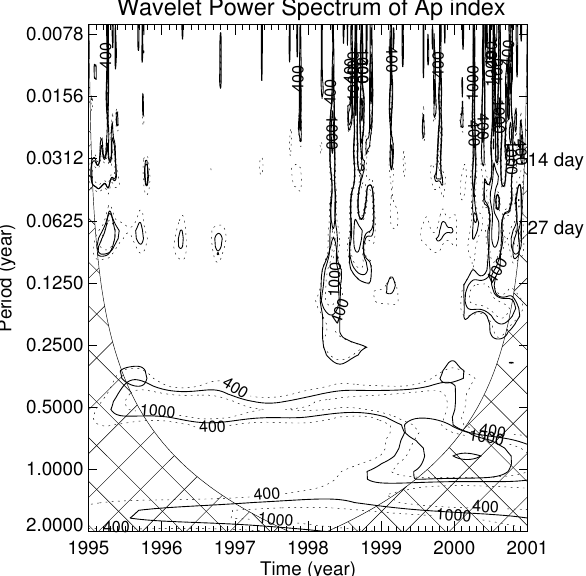
Fig. 11. Wavelet spectra of ion temperature during the daytime. Other details same as in Fig. 1.